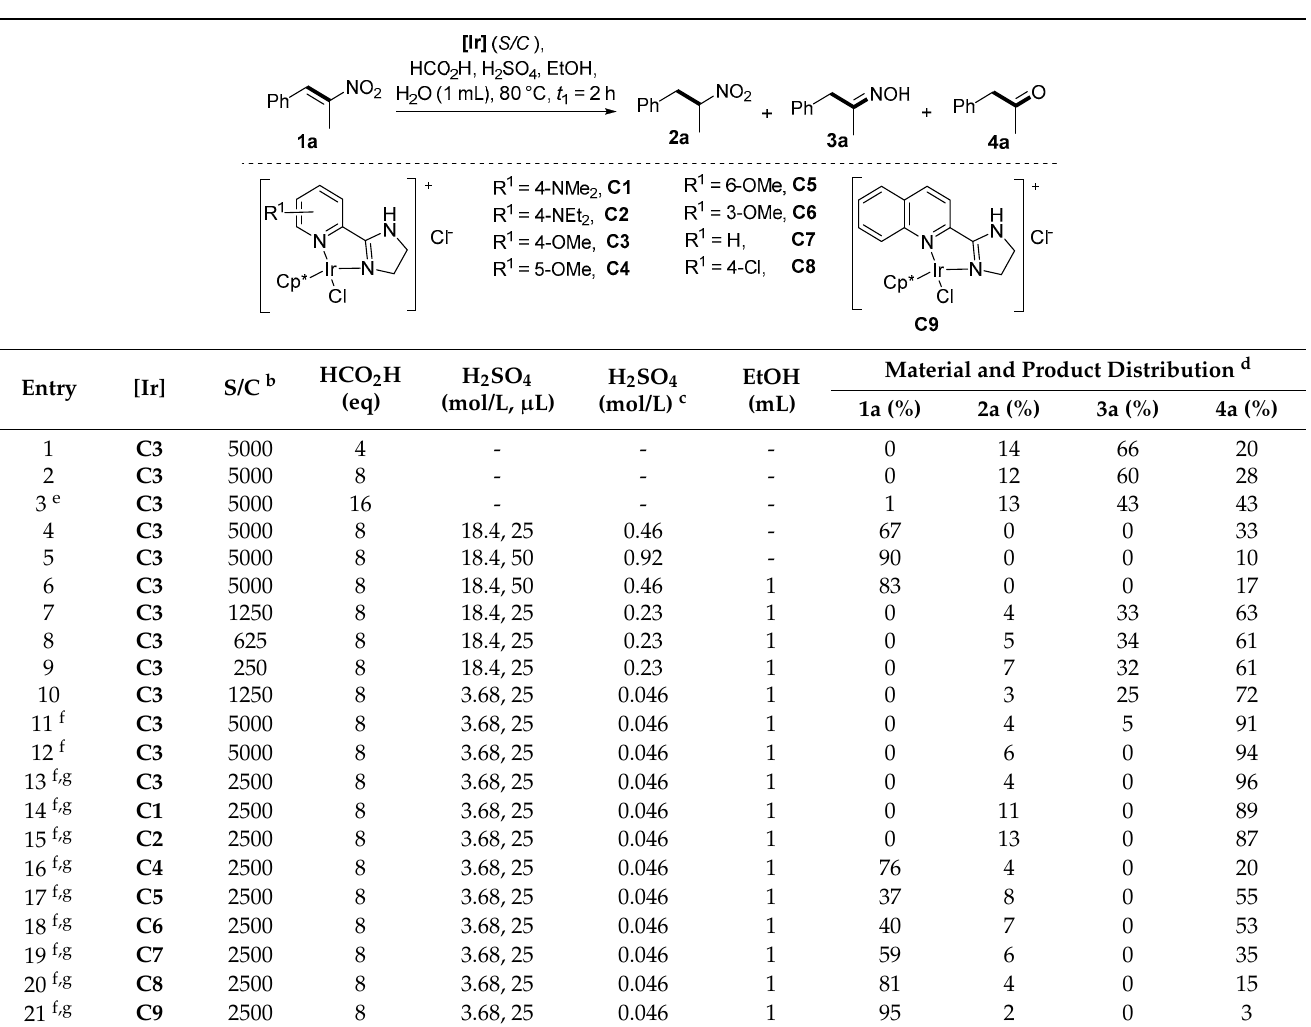
Table 1. Optimization of reaction conditions a .